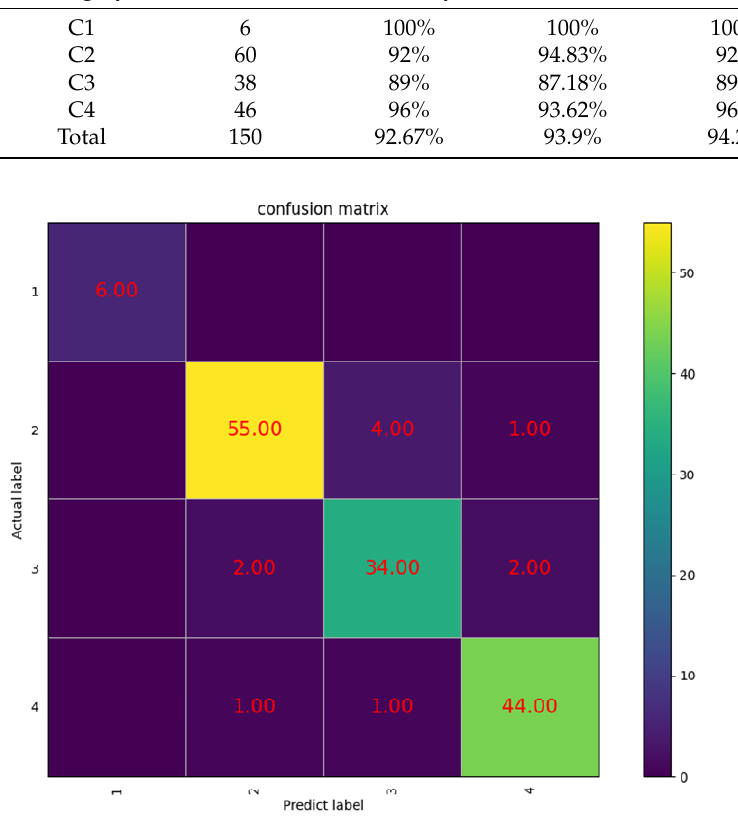
Figure 13. Confusion matrix of DSFF-DenseNet-DT on the self-built datasets.